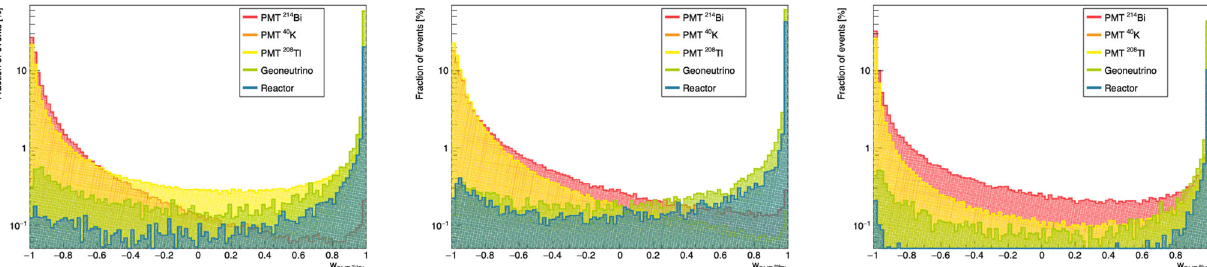
Fig. 6 BDTdiscriminantvariabledistributionsforPMTs(inred)andsignal(inblue)incaseof 214 Bi γ -rayhypothesis(left), 208 Tl γ -rayhypothesis (middle), and 40 K γ -ray hypothesis (right) Table 7 The summary of all background and signal contributions at different analysis stages: the resulting post-BDT singles rates of each background inferred from the merged dataset, contributions to the merged dataset pairs, which satisfy pre-optimized selection cuts